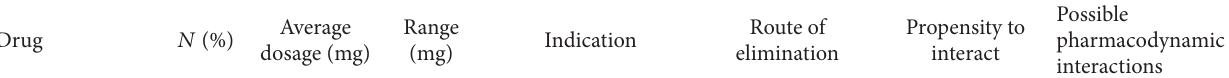
Table 2: AEDs and amitriptyline in pain and other indications 2009–2012 ( 𝑁 = 342) and potential drug interactions. Drug